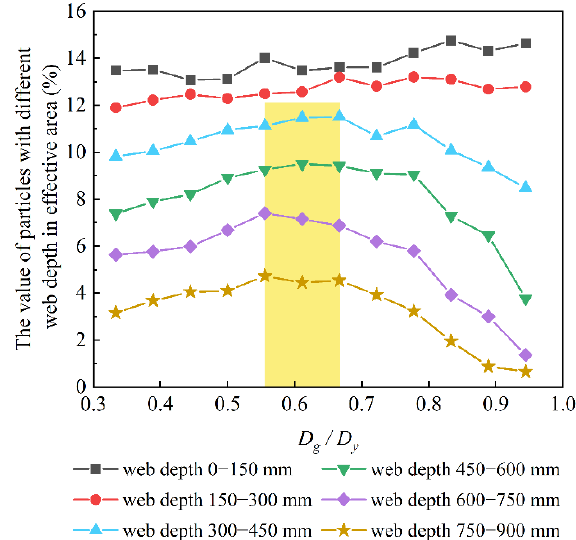
Figure 15. The effect of barrel diameter on conveying performance of particles with different web depths in ejection mode ( D y = 900 mm). depths in ejection mode ( D y = 900